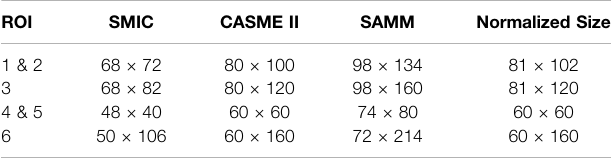
TABLE 2| Thedimensionfor each region on each dataset and the mean between the three databases (CASME II, SAMM, SMIC). ROI SMIC CASME II SAMM